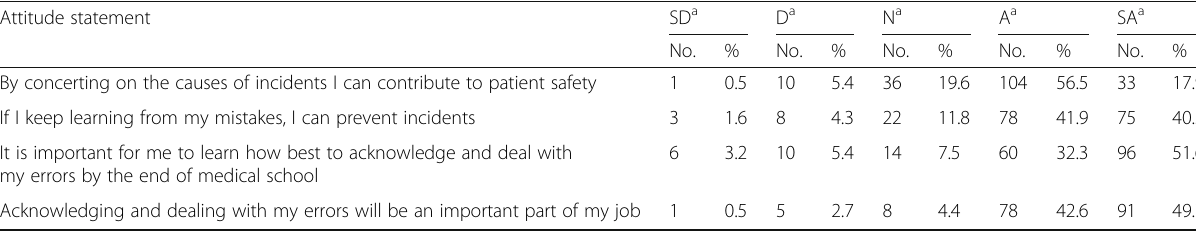
Table 4 Personal attitudes to patient safety among participated physicians Attitude